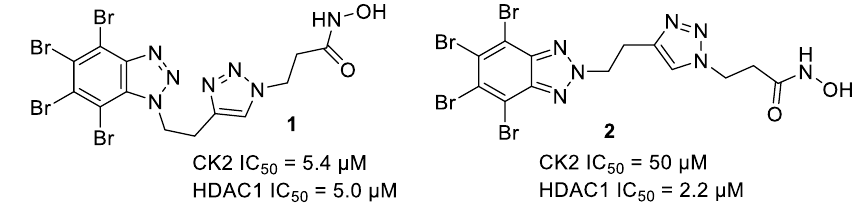
Figure 3. Examples of previously described CK2/HDAC1 dual inhibitors [30].